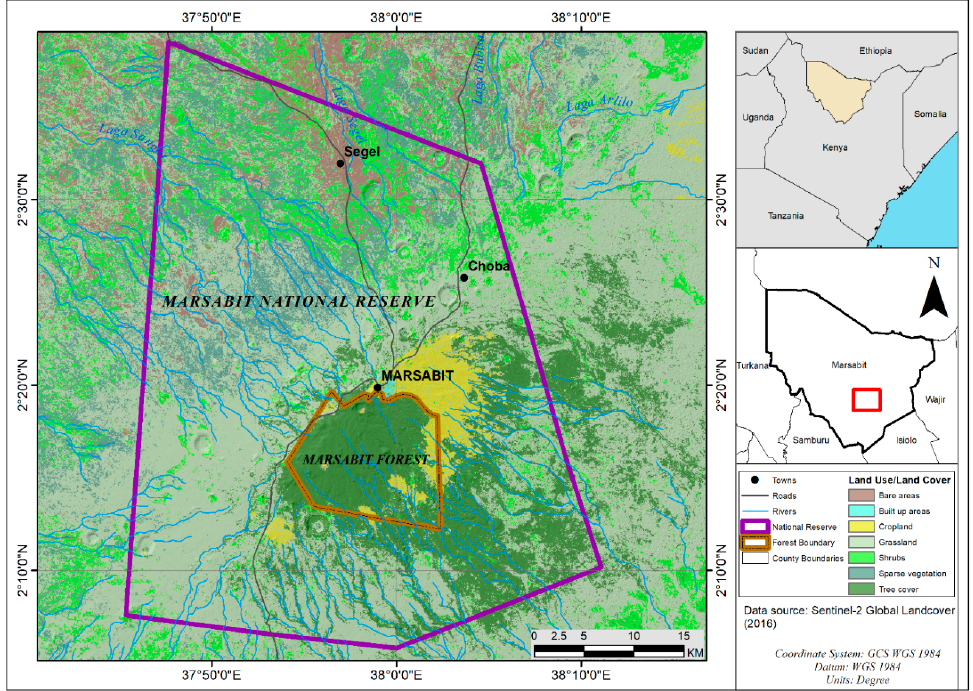
Figure 1. Location of Mt. Marsabit Forest Ecosystem in northern Kenya showing land use and landcover 2016.